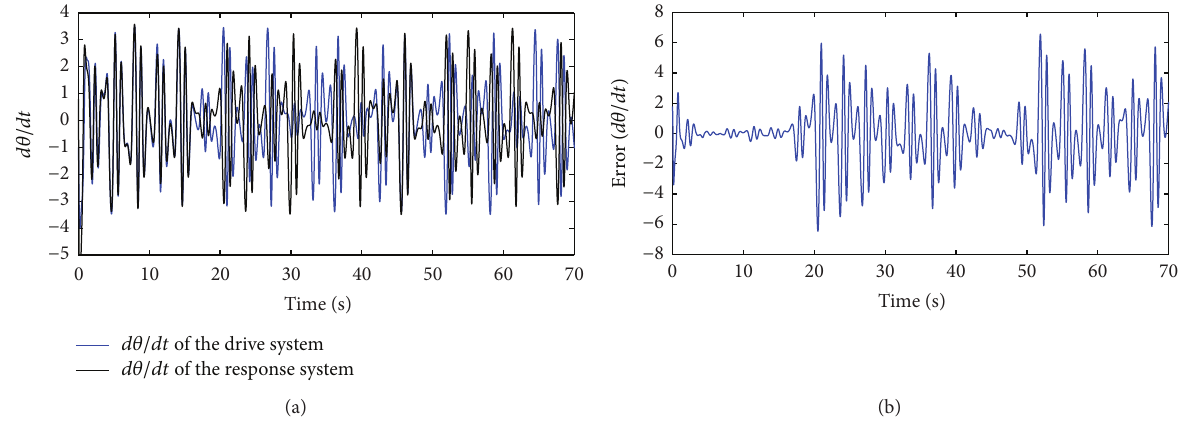
̇𝜃 and error trajectories of unsynchronized chaotic gyros: (a) trajectories of ̇𝜃 .